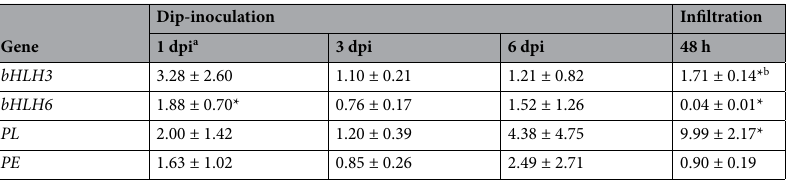
Table 1. Transcription of AvrHah1 targets in tomato leaves after infection with the Xhg avrHah1 ΔDBD mutant. a Gene expression is displayed as the relative expression ratio of transcription levels after infection with the Xhg avrHah1 ΔDBD mutant using the plant response to wildtype Xhg as the calibrator (i.e., the response to wildtype Xhg is set to 1.0). b Asterisks indicate statistical differences in plant gene expression after treatment with the Xhg avrHah1 mutant compared to plant gene expression after treatment with wildtype Xhg using t-test ( P < 0.05).